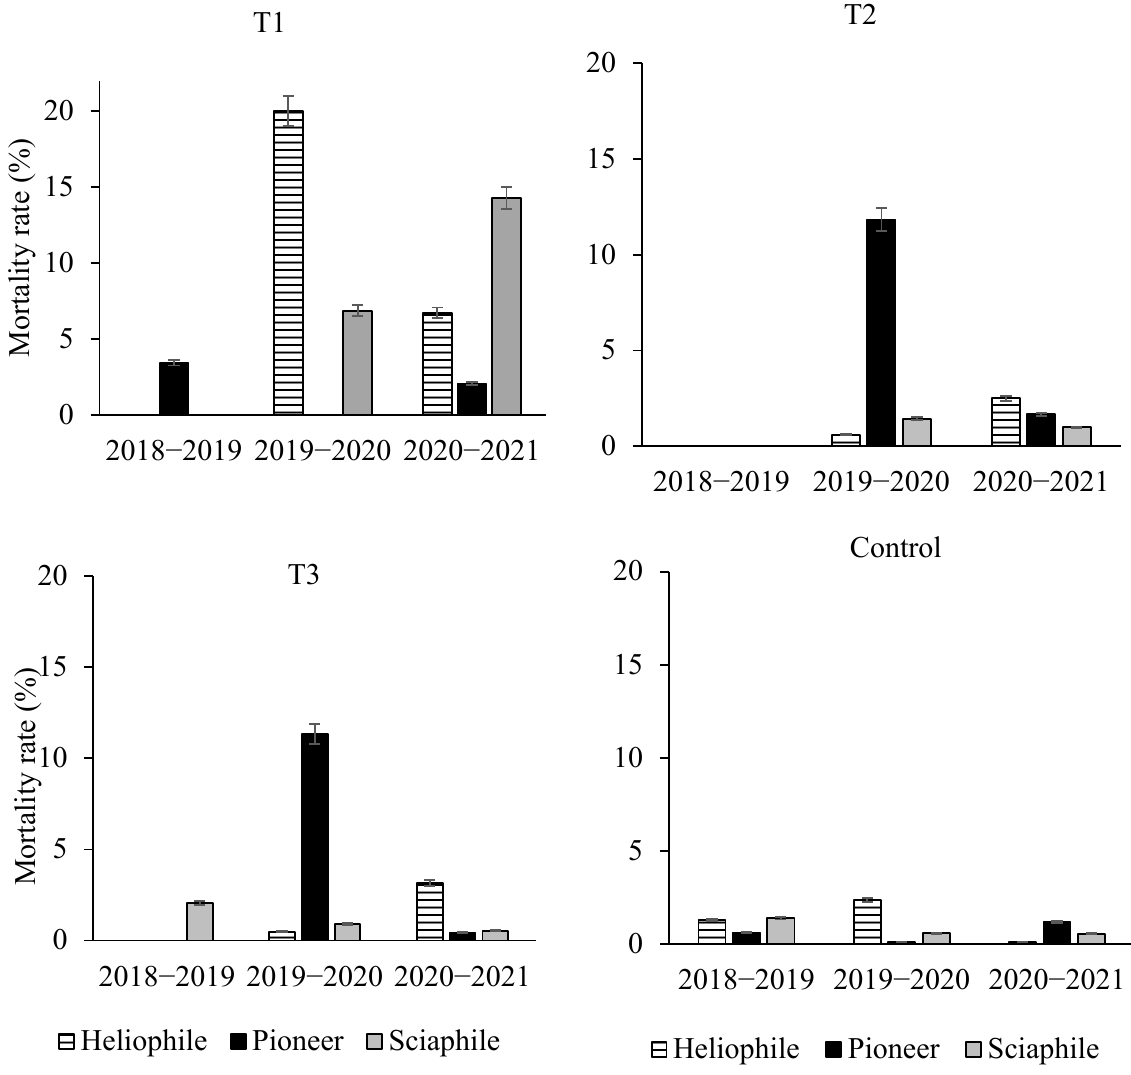
Figure 6. Tree mortality rate by treatment. T1 = cocoa plantations which were regularly maintained and exploited, T2 = cocoa plantations which were not maintained but exploited, T3 = cocoa plantations without activities, and Control = a forest